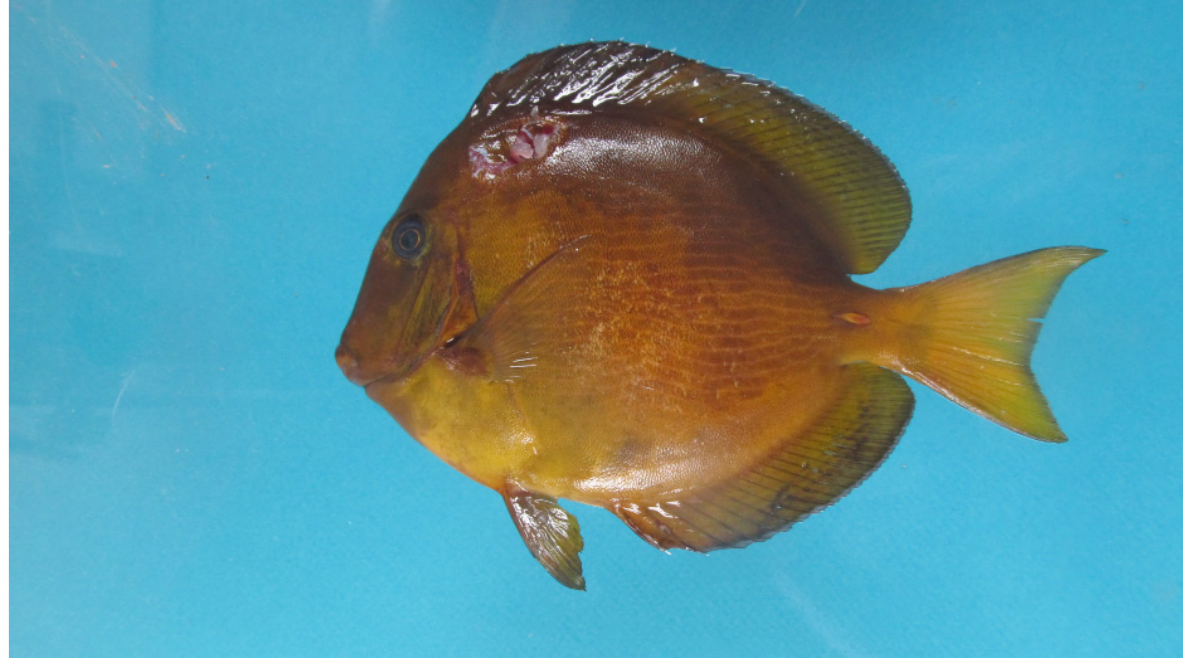
from Israel (Golani and Sonin 1996) and from Algeria (Hemida et al. 2004).